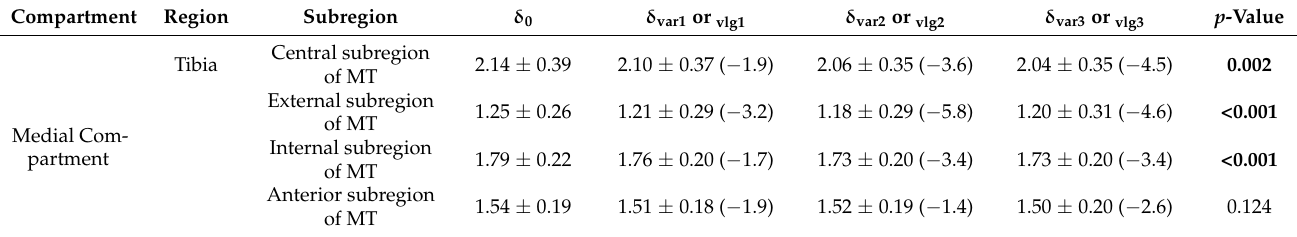
Figure A2. Workflow of image acquisition and analysis. For each joint specimen and loading configuration, PD-weighted fat-saturated (PD-fs) sequences were acquired in the axial (ax), coronal (cor) and sagittal (sag) orientation as well as 3D water-selective cartilage scans (WATSc), and quantitative T2 and T1 ρ mapping sequences. The MR data were then analysed to reconstruct quantitative T2 and T1 ρ maps, while morphologic sequences were used for segmentation and morphometric analyses. Table A1. Mean cartilage thickness of the distinct subregions of the medial and lateral femur and tibia as a function of loading. Mean ± standard deviation (mm) (mean percentage change versus δ 0 (%)). Statistical analysis was performed using repeated measures ANOVA and statistically significant findings are highlighted in bold type . Abbreviations: central medial femur (cMF), central lateral femur (cLF), medial tibia (MT), lateral tibia (LT). Please refer to Table 2 for additional details on table